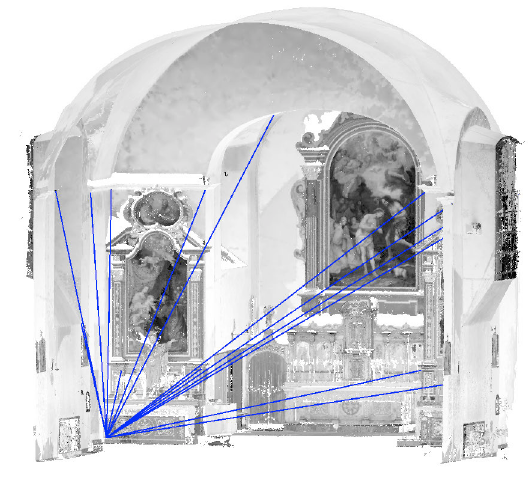
Figure 6: Laser scanner point cloud with reconstruction of original photo position using control points